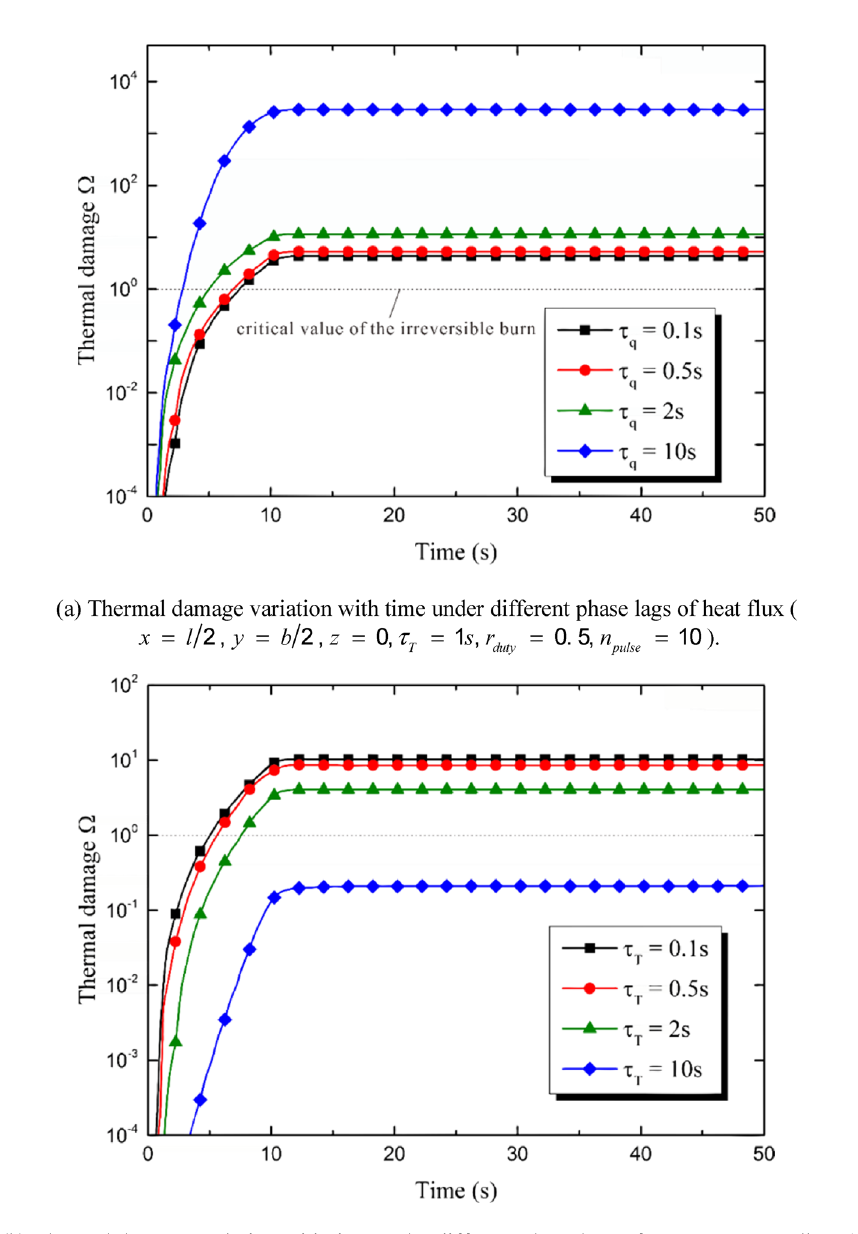
Figure 8. Influences of the phase lags on the thermal damage induced by the multi-pulse